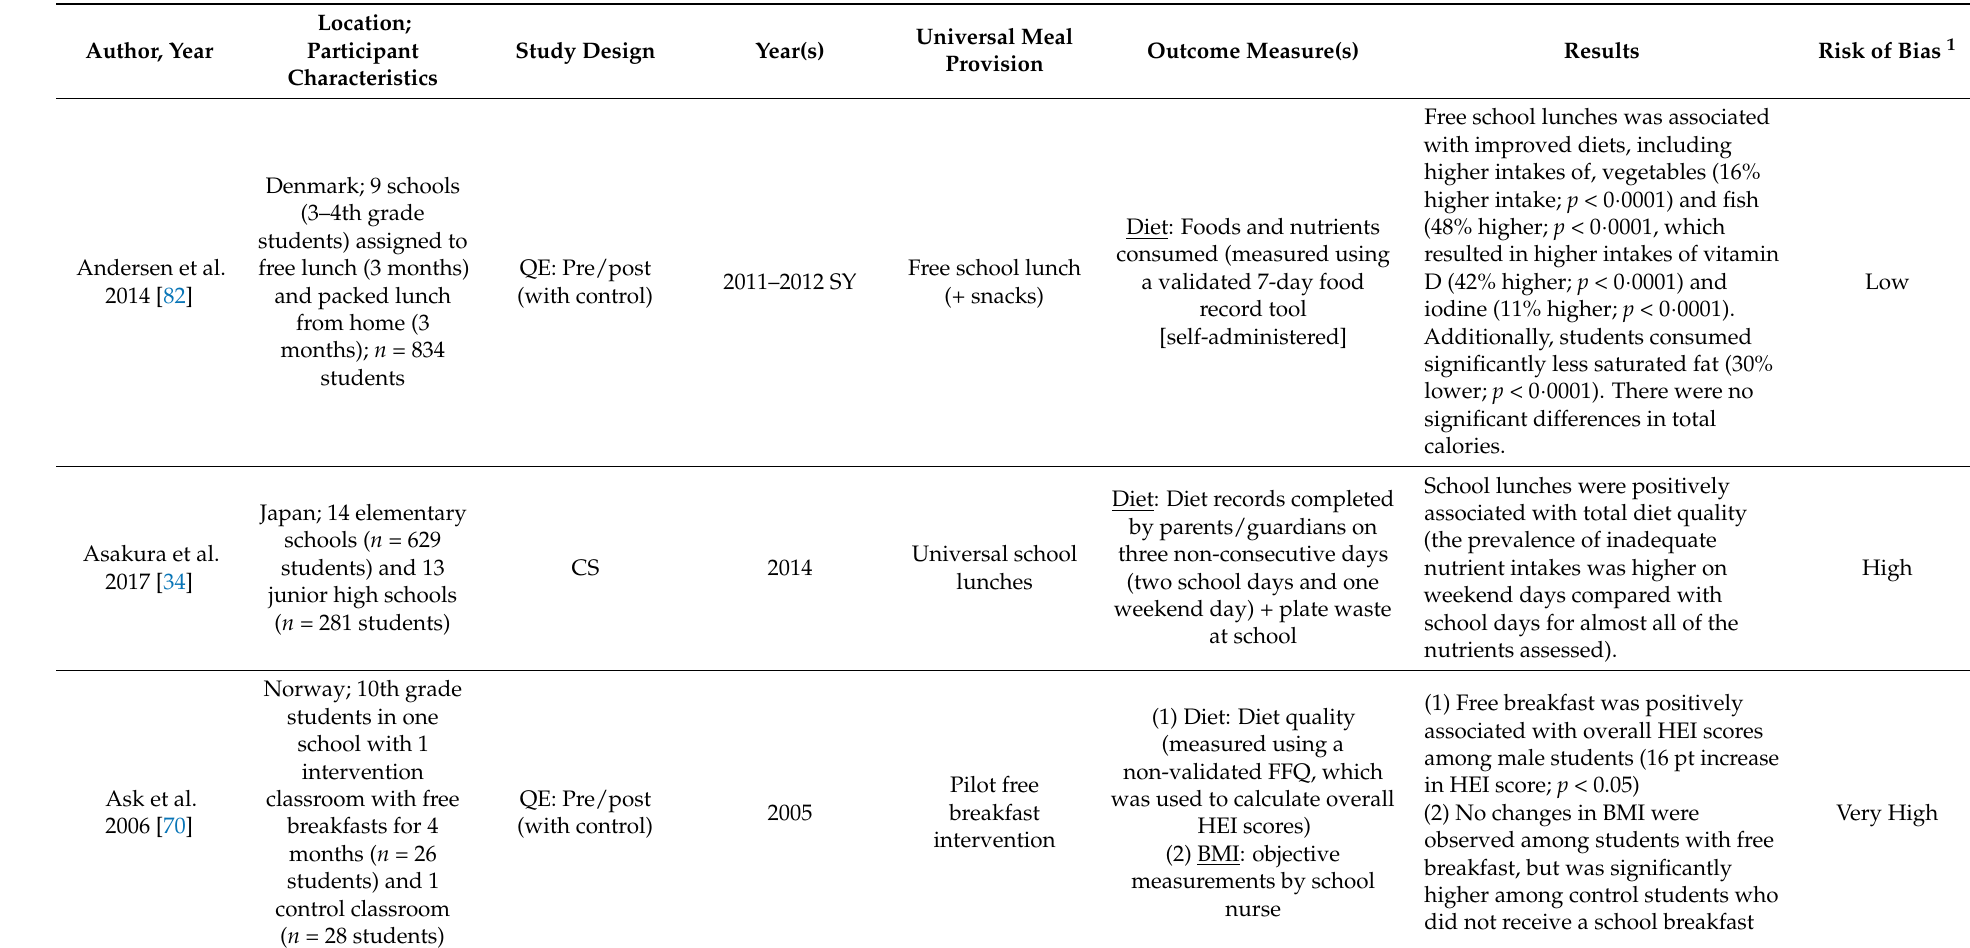
Table 2. Characteristics of studies conducted in other (non-U.S.) OECD countries included in the systematic